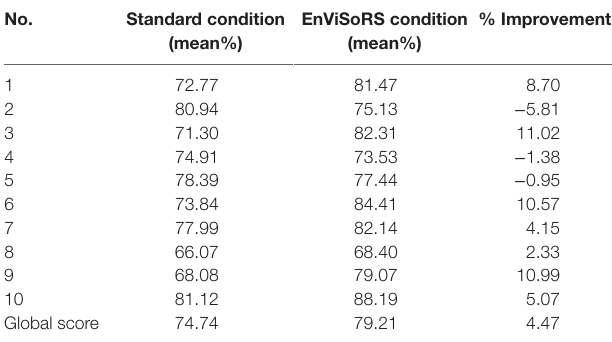
TaBle 5 | sUs questionnaire results: score obtained for each question of Table 1 from the evaluation of the standard system vs. using enVisors, and % of improvement.